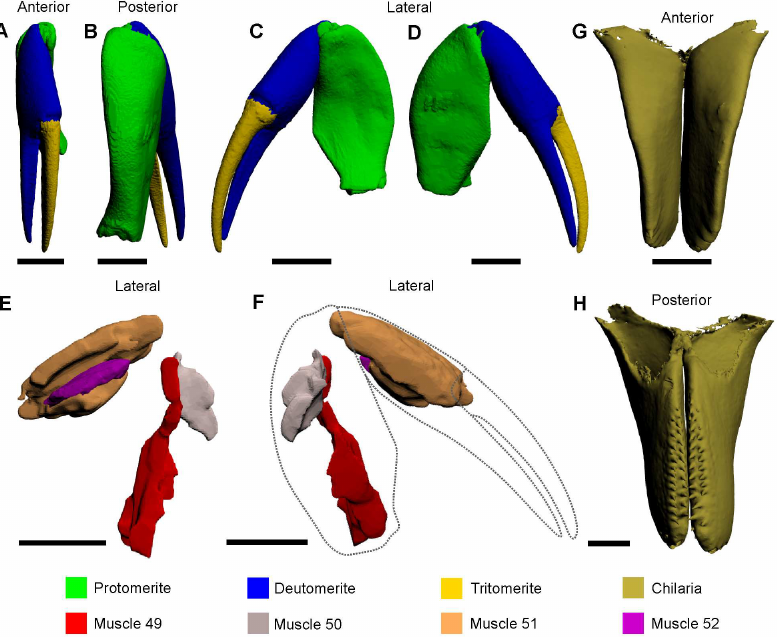
Fig 2. 3D reconstruction of a single chelicera (A–D) and muscles therein (E, F) and the chilaria (G, H), as modelled from iodine staining and micro-CT–scanning. The 3D versions of these files are available in the Supporting Information (S2 and S6 Figs). Dotted lines in F outline the protomerite, deutomerite and tritomerite to indicate the relative positions of the muscles. All scale bars 5